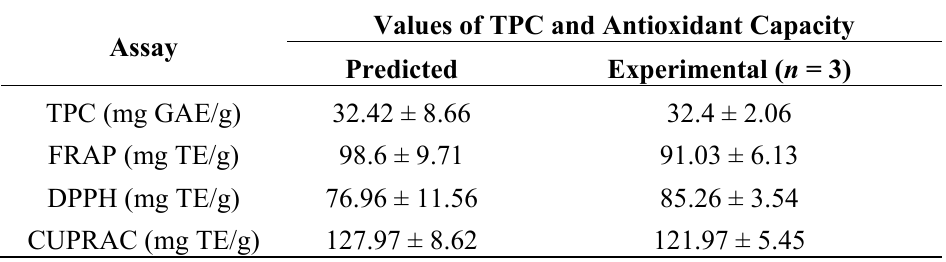
Table 4. Validation of the experimental model. GAE, gallic acid equivalents.